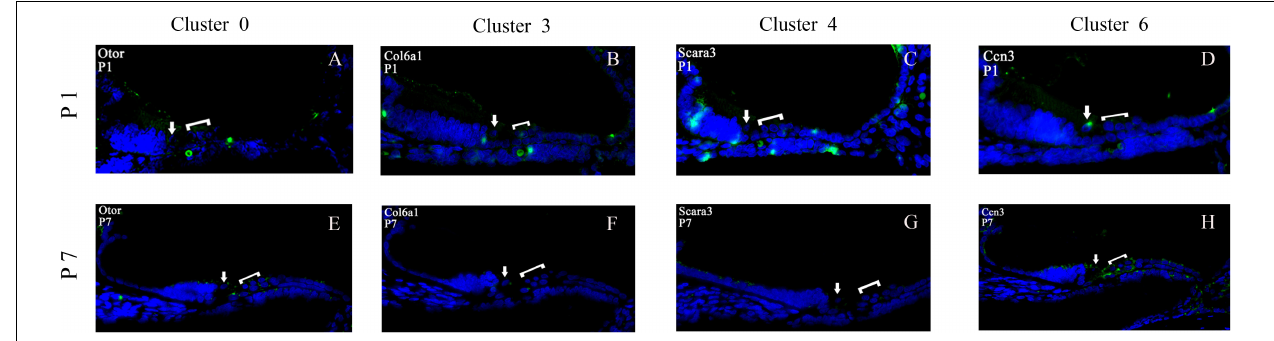
FIGURE 12 | Validation of high expression gene of GER cell clusters at P1 and P7. Otor was high and nearly restricted expressed to the whole GER cells at P1 (green color), and down-regulated expression in GER at P7 (A,E) . Col6a1 was significantly expressed in EGR region of the cochlea at P1, but almost disappeared at P7 (B,F) . Scara3 was centrally expressed in the lateral wall of the GER region of the cochlea during the P1 period, but showed a significantly reduced scattered expression during the P7 period (C,G) . The location of Ccn3 expression in the GER region of the cochlea during P1 overlapped a lot with Otor, but the expression was also significantly reduced at P7 (D,H) . For all panels, the IHC is indicated with an arrow and the three OHCs are indicated by a